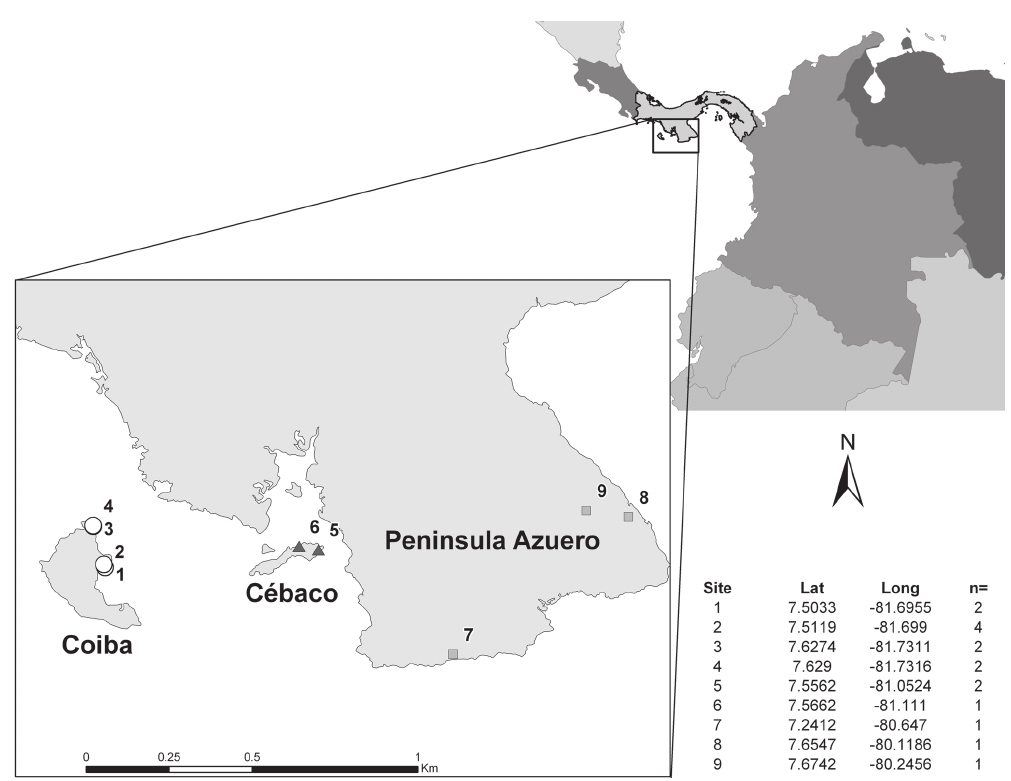
Figure 1. Specimen localities with presented corresponding latitude and longitude and number of individuals sequenced. Circles indi- cate the four localities on Isla Coiba, triangles for the 2 localities on Isla Cébaco, and squares for the three localities on Peninsula